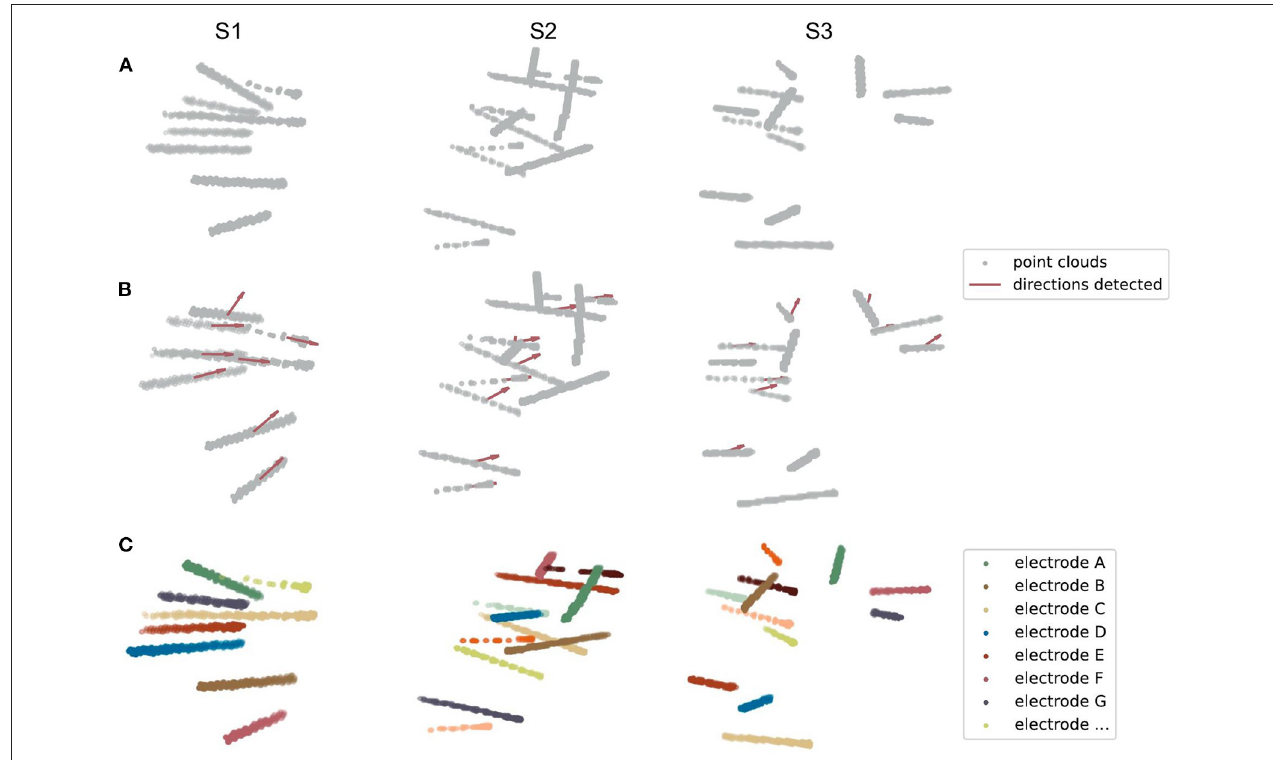
FIGURE 5 | Three examples of electrode point clouds have been 3D Hough-transformed and then clustered using the Gaussian Mixture Model. (A) The initial point clouds of electrodes are extracted from the CT intracranial image of an individual after several preprocessing steps. (B) The centroids and directions (showing by the red arrows) of SEEG electrodes are detected by the Hough Transform algorithm of a line in 3D coordinates. (C) The clustered electrodes are marked using different colors, after applying the Gaussian Mixture Model and the prior knowledge of the centroids and directions of clusters generated from (B)